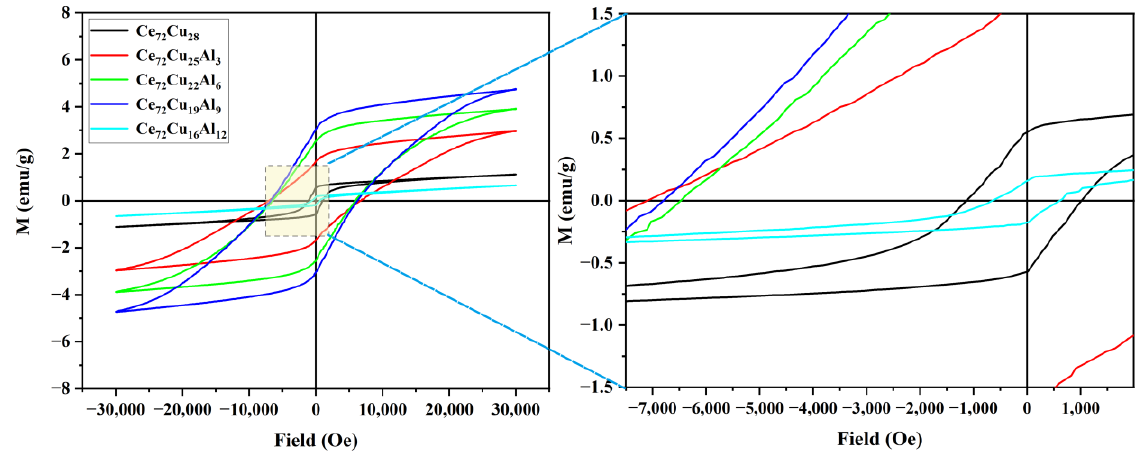
Figure 4. VSM diagram of Ce 72 Cu 28-x Al x alloys and their partial magnification. To determine the effect of Ce-based alloy binders with low melting points and weak magnetic characteristics on the magnetic properties of the Sm-Fe-N magnet, the Ce 72 Cu 28- x Al x /Sm 2 Fe 17 N green compacts with 5 wt.% alloy addition were consolidated by the hot- press sintering method. The appearance, density and magnetic properties of the bonded magnets are shown in Figure 5. With the increase in Al content, the density of the magnets decreases gradually, from 6.66 g/cm 3 at x = 0 at.% to 6.28 g/cm 3 at x = 12 at.%. In contrast, the remanence, coercivity, and maximum magnetic energy product increase first and then decrease, reaching the maximum values of 10.12 kGs, 5.63 kOe, and 21.06 MGOe when the atomic percentage of Al is 6 at.%. Figure 5. Change in properties of Sm-Fe-N hot-pressing magnets by adding 5 wt.% Ce 72 Cu 28-x Al x with different Al contents and ( a ) appearance ( b ) density, ( c ) demagnetization curves, ( d ) rema- nence, ( e ) intrinsic coercivity, and ( f ) maximum energy product of magnets. The decrease in magnet density is related to the change in density of Ce 72 Cu 28-x Al x (x = 0, 3, 6, 9, 12) alloys. Figure 6 shows the variation in density of Ce 72 Cu 28-x Al x (x = 0, 3, 6, 9,